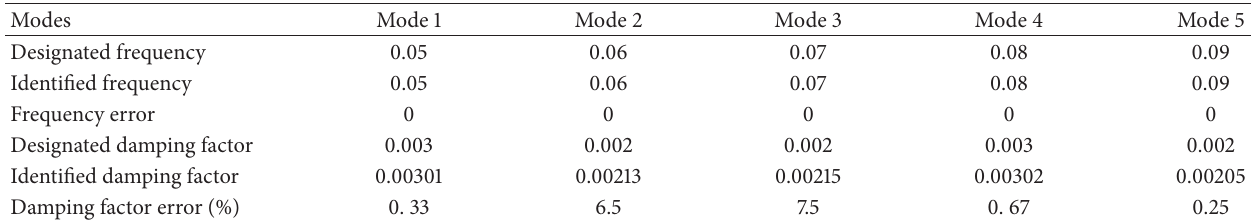
Figure 3: 2D amplitude spectrum estimated by the proposed approach (the response of the first DOF 𝑥 1 is chosen): (a) 2D amplitude of 𝑥 1 ; (b) contour of the amplitude spectrum in the 𝑓, 𝜎 plane. Table 1: Identified spectrum